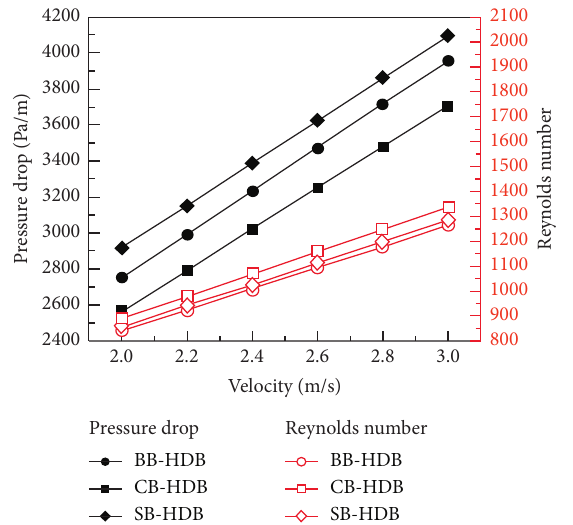
Figure 8: Calculated pressure drop and Reynold’s number for SB- HDB, BB-HDB, and